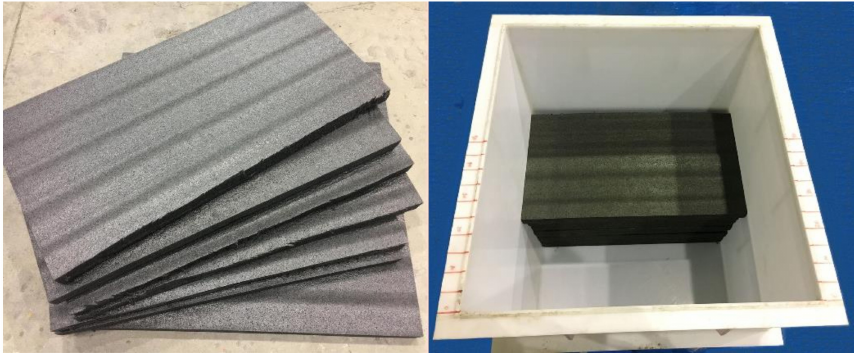
Figure 11. High resistance filler and model container.